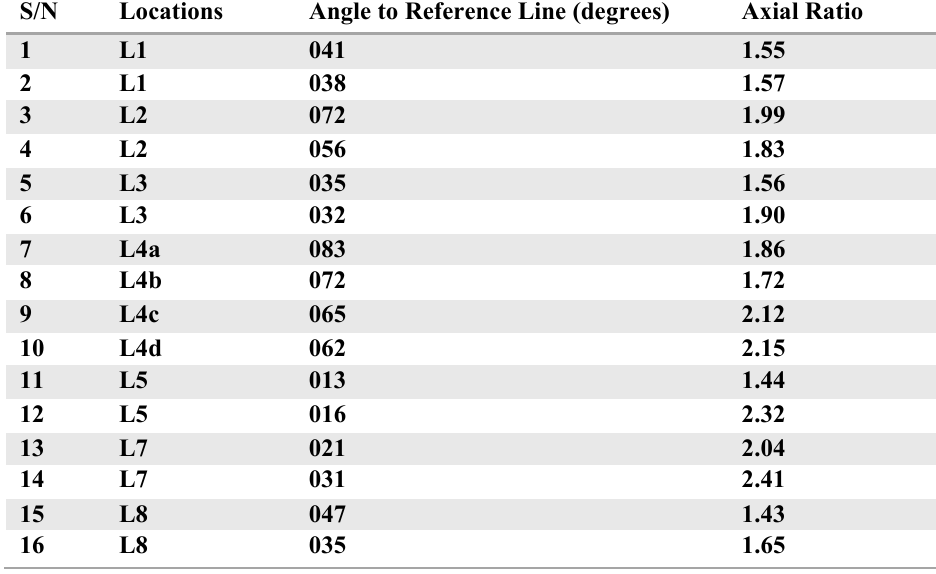
Figure 8: Digitization screen of Fry halos using GeoFryPlots 3.1 software Table 1: Locations of obtained sample with respective ratios of their axes and reference line angles S/N Locations Angle to Reference Line (degrees) Axial